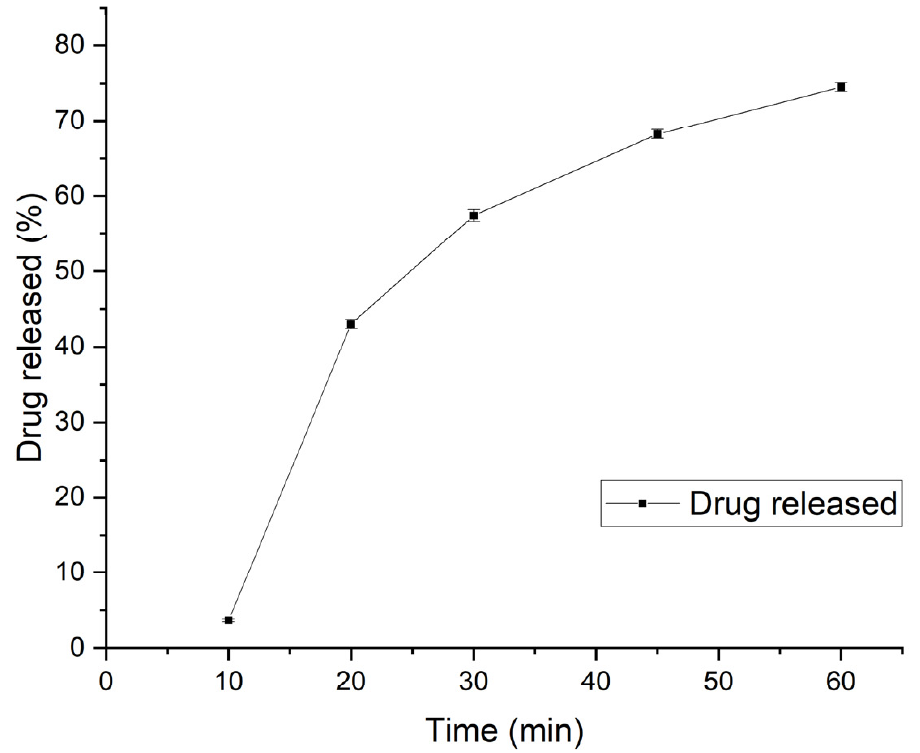
Figure 8. In vitro dissolution profile of CBZ ODMT.